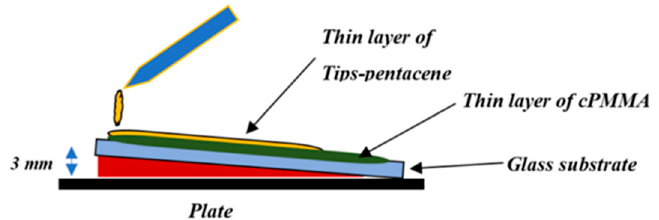
Figure 1. Scheme diagram of drop casting on a substrate with angle of 7 ◦ .